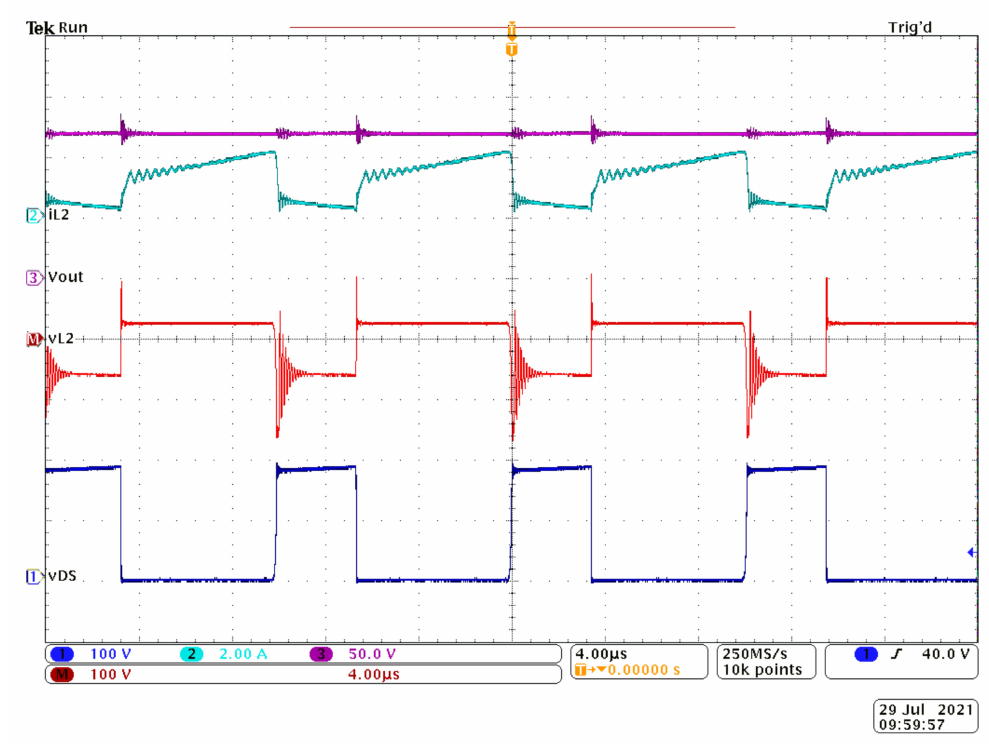
Figure 21. Oscilloscope waveforms: drain-to-source voltage (dark blue— v DS ); voltage across L 2 (red— v L 2 ); current through L 2 (cyan— i L 2 ) and output voltage (purple— V out ).